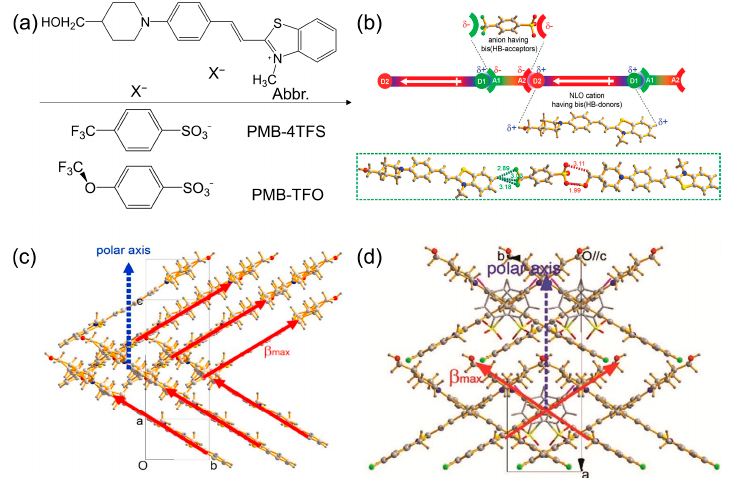
Figure 11. ( a ) Chemical structures of benzothiazolium-based NLO crystals; ( b ) PMB-4TFS double head-to-tail hydrogen bond assembly [27]; ( c ) arrangement of PMB cations in PMB-TFO [51]; and ( d ) arrangement of PFB-CBS crystals along the c -axis [50].